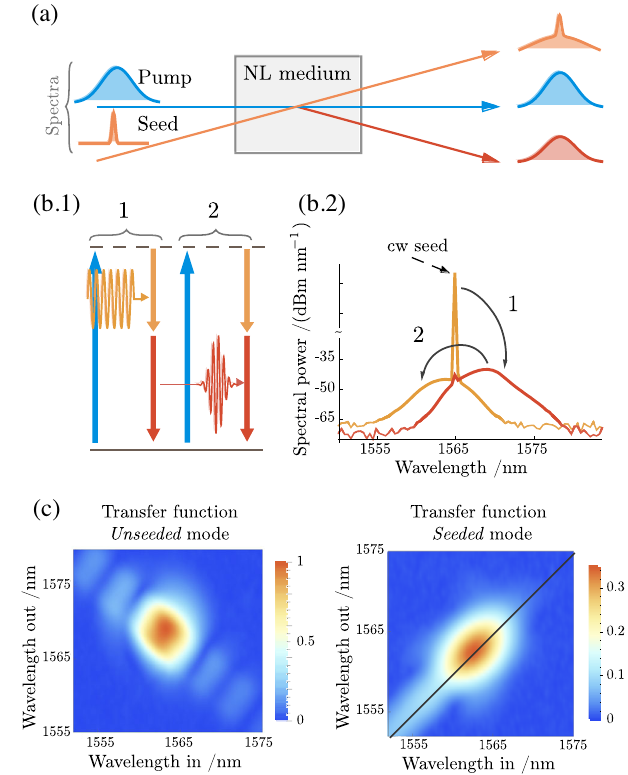
FIG. 1. (a) Schematic of an extended SET experiment, includ- ing the broadband light generated in the seeding beam through a cascaded DFG process. (b.1) Cascaded stimulated emission in a PDC crystal. Seeding one of the two down-conversion modes with a continuous-wave (cw) field (represented in orange), bright light is generated through DFG between the pump (represented in blue) and the seed. The DFG signal (represented in red) acts as a seed for a second DFG interaction with the pump field, leading to broadband light generation in the mode that was originally seeded. The process is repeated with decreasing strength. (b.2) Measured spectra of cascaded stimu- lated emission for a nearly degenerate type-II PDC source pumped with a pulse train centered at 783 nm. Seeding with a cw laser at 1565 nm, we measured broadband signals in the opposite polarization (red) as well as in the same polarization as the seed (orange). (c) Full spectral response of the PDC process reconstructed by scanning the seed wavelength. The cw seed contribution was subtracted from the spectra. The spectral responses are normalized to the maximum of the TF corre- sponding to the unseeded